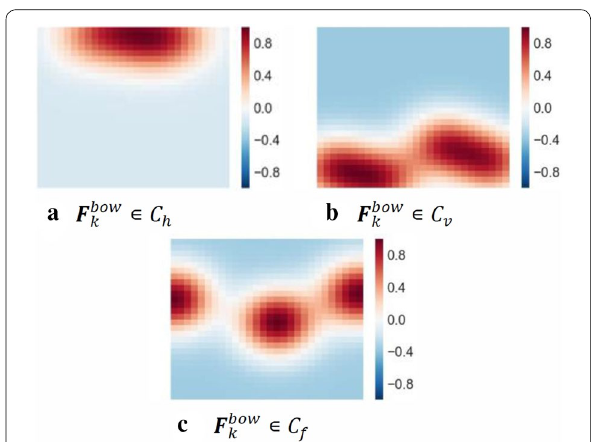
Fig. 17 Representatives of BoW vectors for the training data